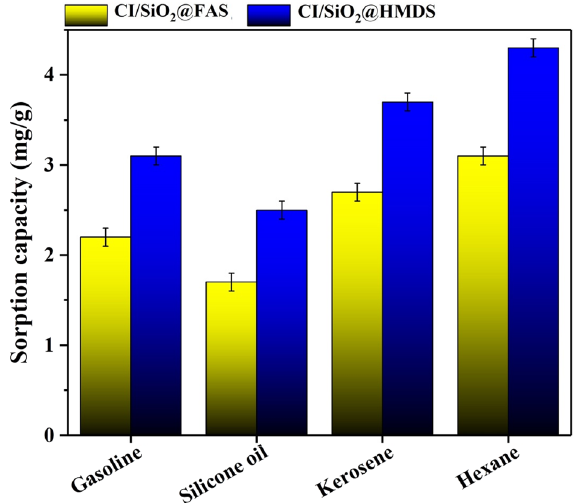
Figure 6. The sorption capacity of CI/SiO 2 @FAS, and CI/SiO 2 @HMDS.